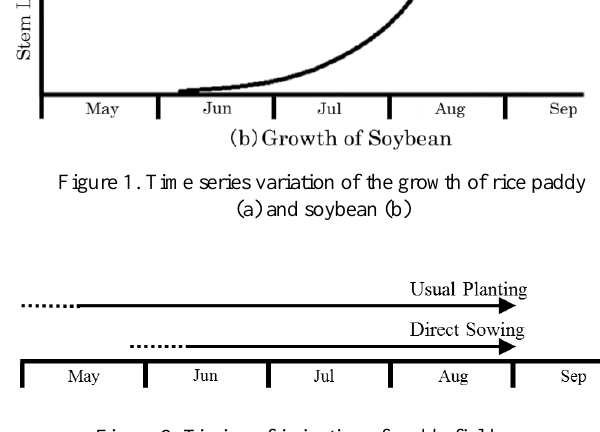
Figure 1. Time series variation of the growth of rice paddy